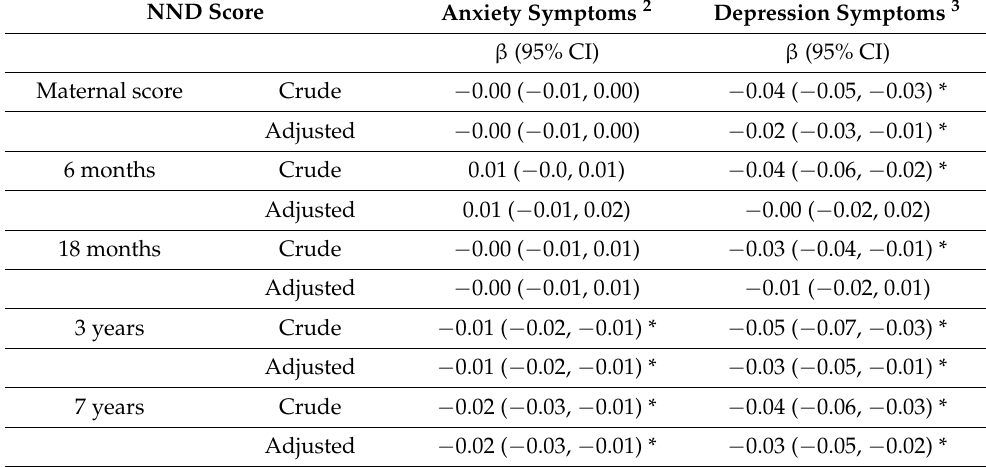
Table 4. Associations between NND as continuous score and the anxiety and depression symptom scores, respectively. Crude and adjusted 1 linear regression. The symptoms scales are ranged from low to higher degree of symptoms.